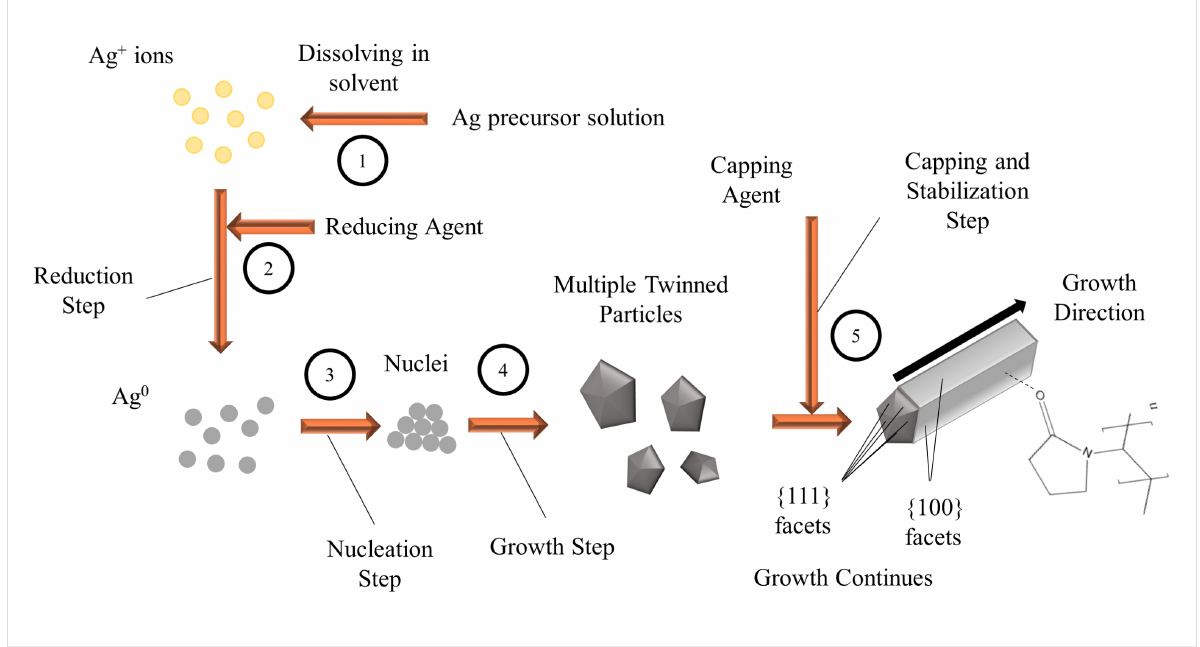
Figure 2: Synthesis steps and reaction mechanism for AgNW polyol